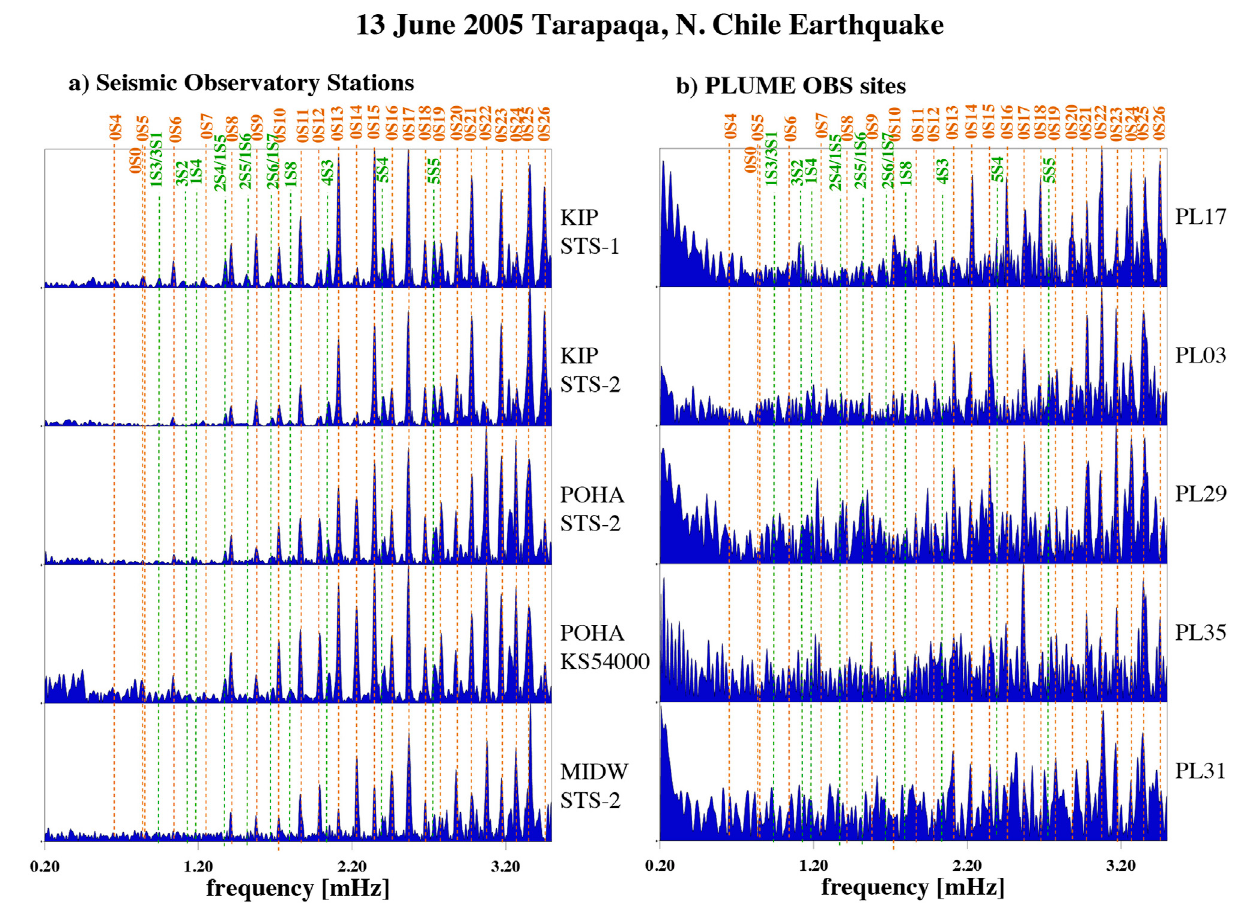
FIGURE5| Normalizedrawvertical-componentspectrafortheJune13,2005Tarapaqa,NorthernChileearthquakeof25-hourlongsegments,starting1.5 hafter the event time. (A) Spectraat stations oftheGSN; (B) Spectraat fi ve OBSsites with the bestsignal-to-noise ratio.See Supplementary Table S1 in the supplement for earthquakeparameters.Thiseventwasmorethanthreetimessmallerthanthe1998BallenyIslandearthquake(see Figure3 ).Yet,weareabletoobservenormalmodes on unburied OBSs.